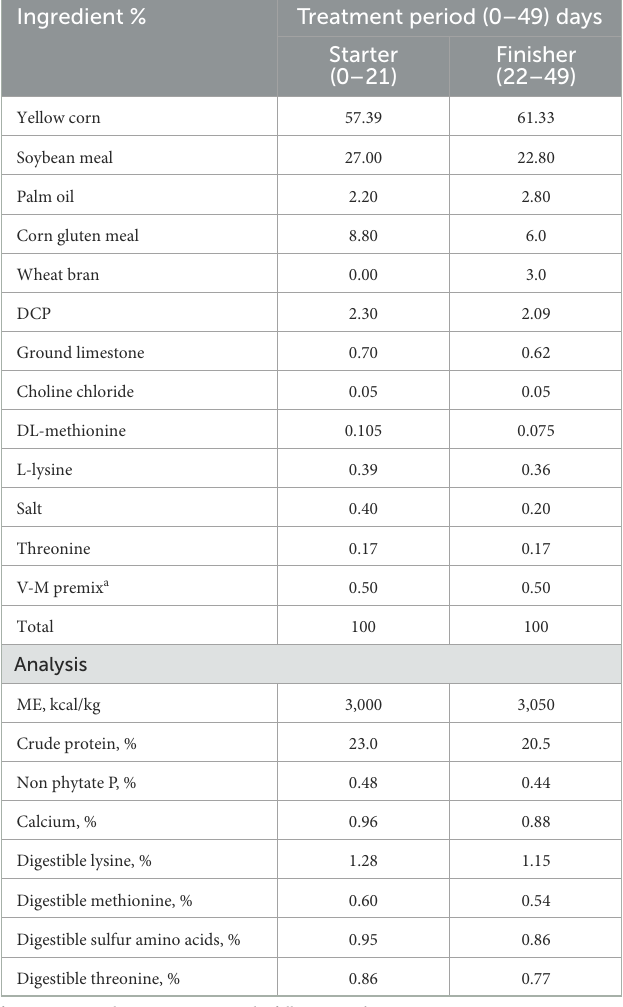
TABLE 1 Dietary composition during starter and finisher